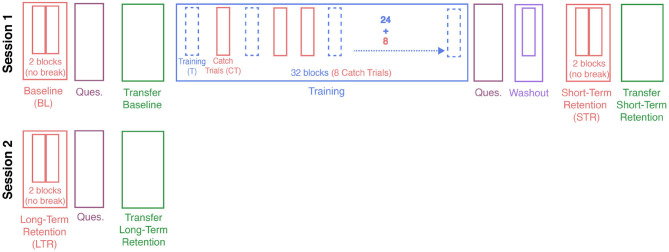
Experimental protocol. Participants were randomly allocated to one of four training groups: Control, End-effector MPC, Ball MPC, and Haptic Guidance. Participants completed two sessions, with 1–3 days between sessions. Training blocks (x32) and catch-trials blocks (x8) were used to analyze the effect of training with different assistance strategies on the metrics considered. Motor learning was evaluated according to changes in the metrics from baseline (BL) to short-term retention (STR) and long-term retention (LTR). Furthermore, transfer learning was evaluated according to changes in the transfer task performance from transfer baseline to transfer short-term retention and long-term retention. After baseline, after training and after long-term retention, participants responded to a selection of statements from the Intrinsic Motivation Inventory (IMI) and agency section of the embodiment questionnaire (Ques.).